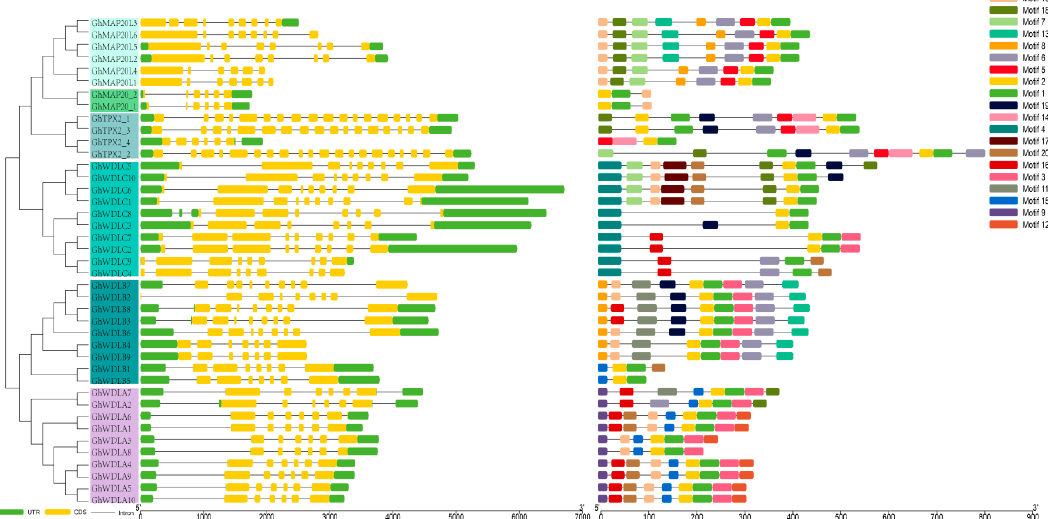
Figure 2. Phylogenetic relationship, gene structure predictions, and conversed protein motif analysis of GhTPX2 family: ( a ) A neighbor-joining phylogenetic tree created using the MEGA6 program: ( b ) Gene structure analysis of GhTPX2 genes, and ( c ) conversed protein motifs.